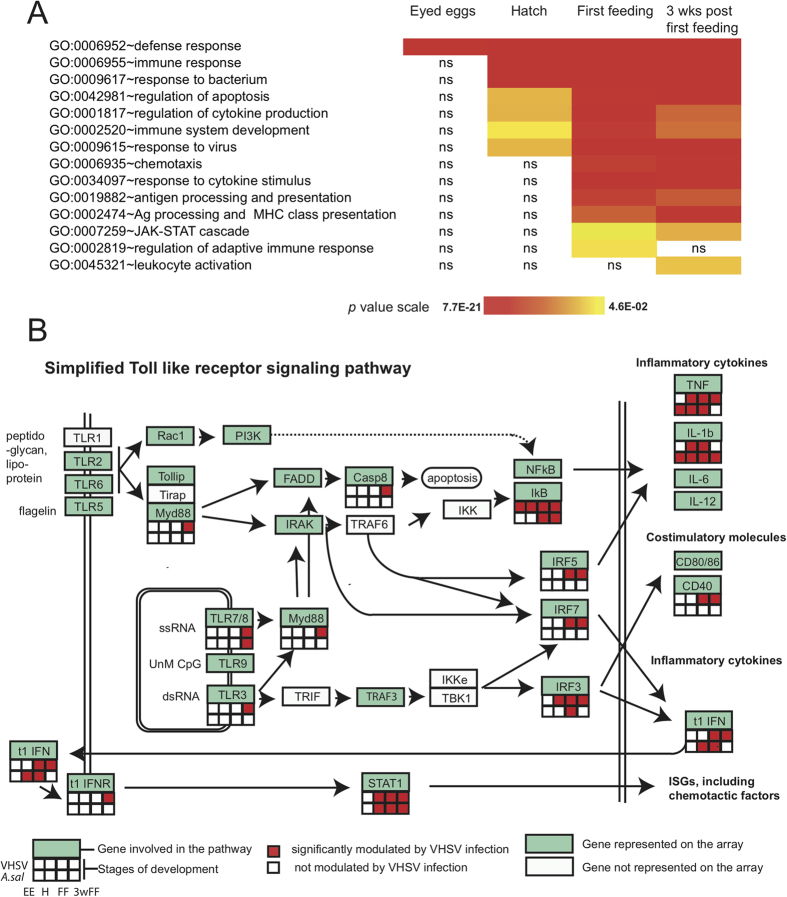
Functional analysis of the transcriptome response to VHSV.(A) Enrichment of selected GO terms (BP, GO fat, from DAVID at http://david.abcc.ncifcrf.gov/) at different stages: eyed eggs “EE”; hatching “H”; first feeding “FF” and 3 weeks post first feeding “3wpFF”. Relative significance is depicted as a heatmap of p values (Benjamini correction). “ns” is for non significant enrichment at a given stage. (B) Analysis of gene expression responses in the TLR pathway upon VHSV infection. Virus modulated genes (adj. p < 0.01; FC > 2 or <0.5) at the four studied developmental stages were mapped on a simplified TLR pathway based on knowledge from mammals. White denotes genes that were not represented on the array platform. Analysis of gene expression in the RLR pathway is represented on figure S1.